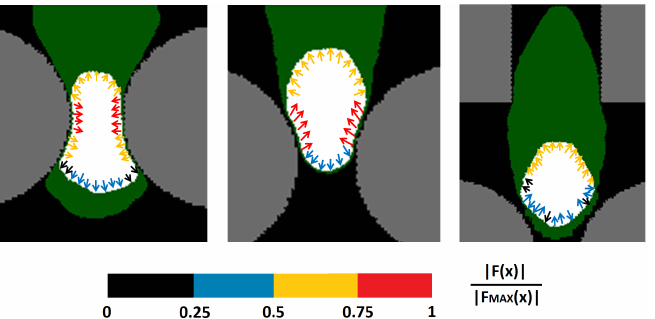
Figure 5. Representative force field at the nuclear boundary at different cell migratory stages. ( Left panel ) cell squeezing within a pair of round pillars. ( Middle panel ) cell overcoming the midpoint of the constriction. ( Right panel ) cell moving within the rectangular elements. For graphical purposes, we have only plotted selected force vectors, which are magnified, with intensity normalized with respect to the maximal value. Force components are defined in Equations (13) and